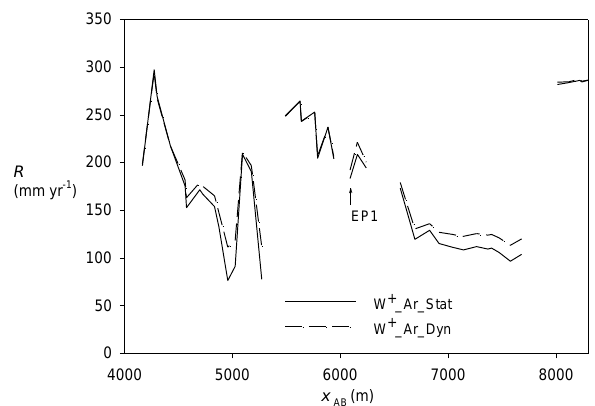
Figure 12. Relationship between the mean groundwater level on day 04/01/2063 (day 4) and 2 Fig. 12. Relationship between the mean groundwater level on days 4 January 2063 (day 4) and 24 September 2063 (day 264) and the 24/09/2063 (day 264) and the difference between the recharge that is simulated for the W + 3 difference between the recharge simulated for the W + scenario with scenario with dynamic and static vegetation models, with ∆ R veg = R dyn – R stat (mm yr -1 ). All 4 dynamic and static vegetation models, with 1R veg = R dyn – R stat shown data points are for the same podzolic soil type. 5 (mmyr − 1 ) . All shown data points are for the same podzolic soil type.